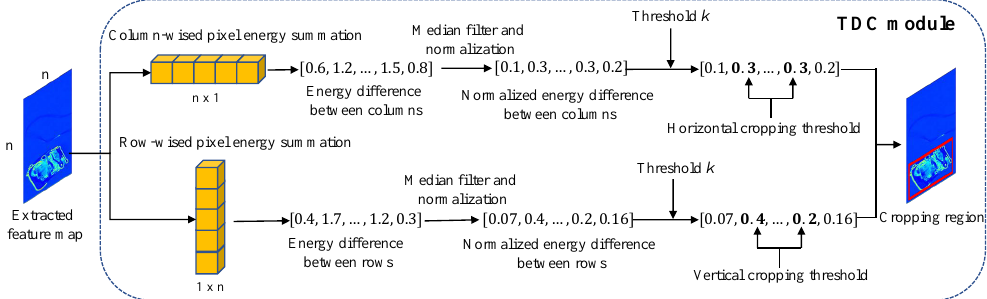
Figure 5. Construction of TDC module by combining the columns/rows wised summation of pixel energy, the median filter to filter out the X-ray artifact spikes, the min-max normalization, and the threshold-based cropping. The cropping region is then combined with the input image to produce the output cropped